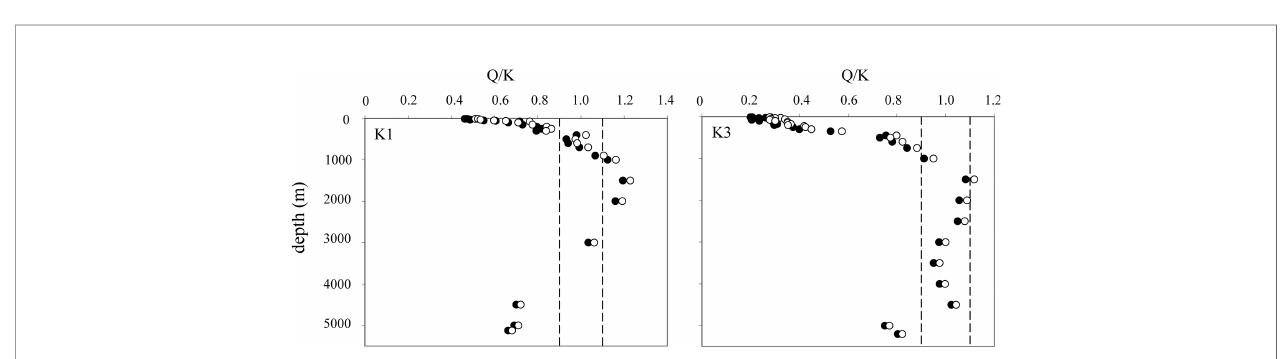
FIGURE 2 | Left panel: vertical pro fi les of 226 Ra at stations old Hale Aloha, K1 and K3 in the North Paci fi c. Right panel: vertical pro fi les of dissolved Ba at stations old Hale Aloha (August 2002 data), K1 and K3 in the North Paci fi c.